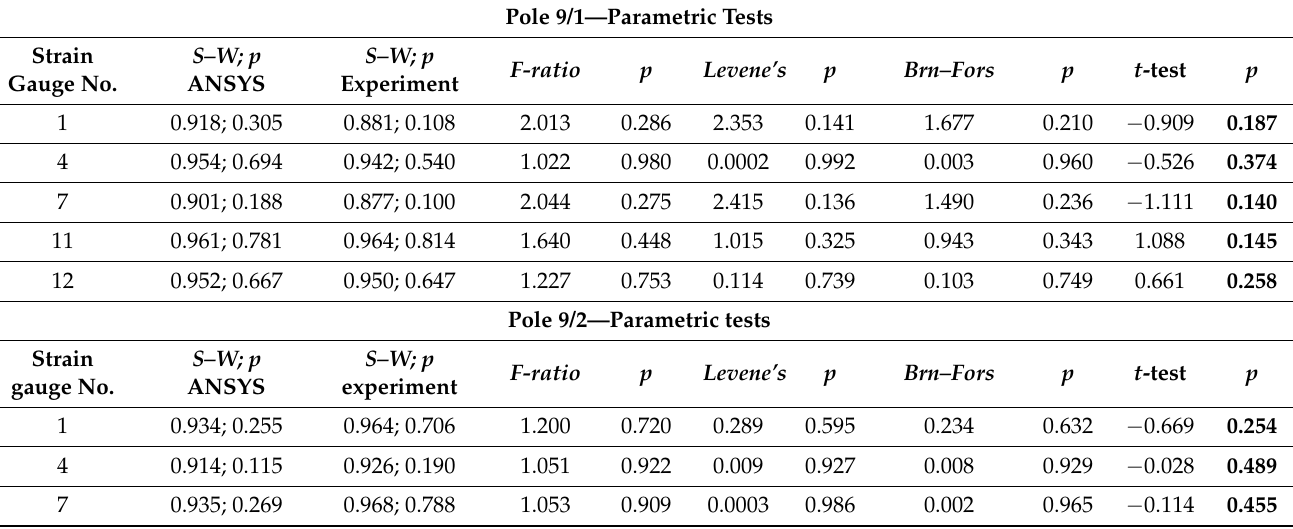
Table 7. Comparison of normal stresses in the vicinity of the inspection opening from numerical simulations carried out in ANSYS software and experimental tests—9 m